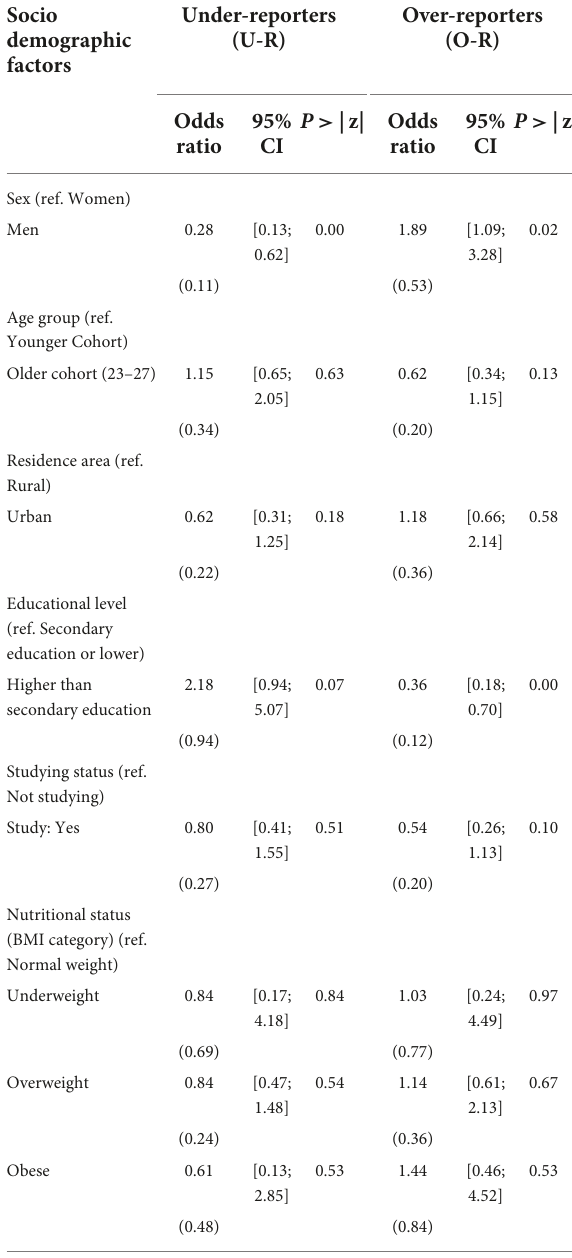
TABLE 4 Association of sociodemographic factors with misreporting